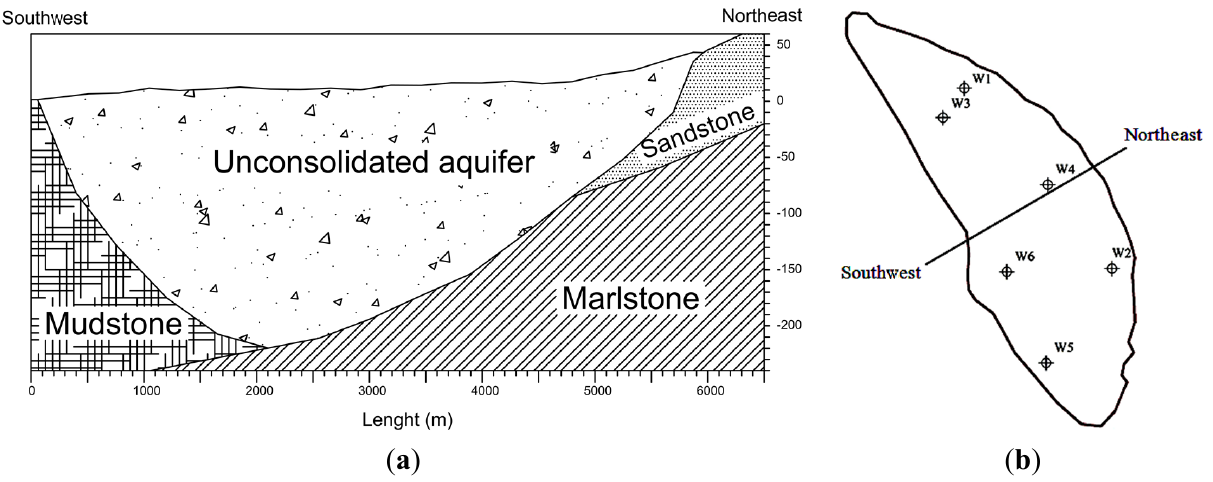
Figure 7. ( a ) Northeast to southwest cross-section of the Merk aquifer; ( b ) location